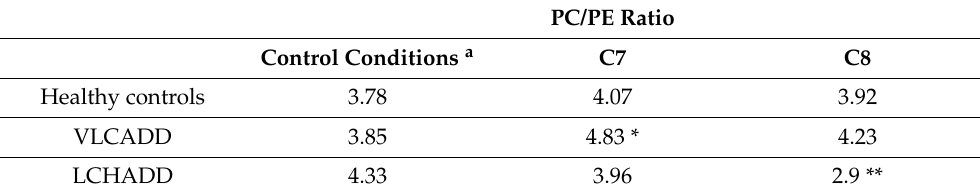
Table 1. Phosphatidylcholine to phosphatidylethanolamine ratio measured in fibroblasts from healthy controls and from VLCADD and LCHADD patients after incubation with either C7 or C8.